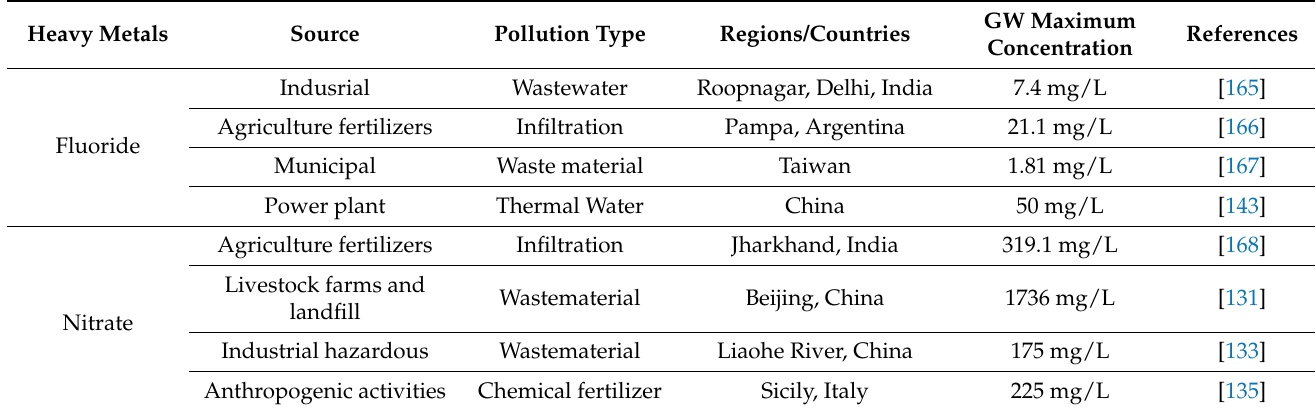
Table 4. Water pollution due to fluorides and nitrates in numerous countries across the